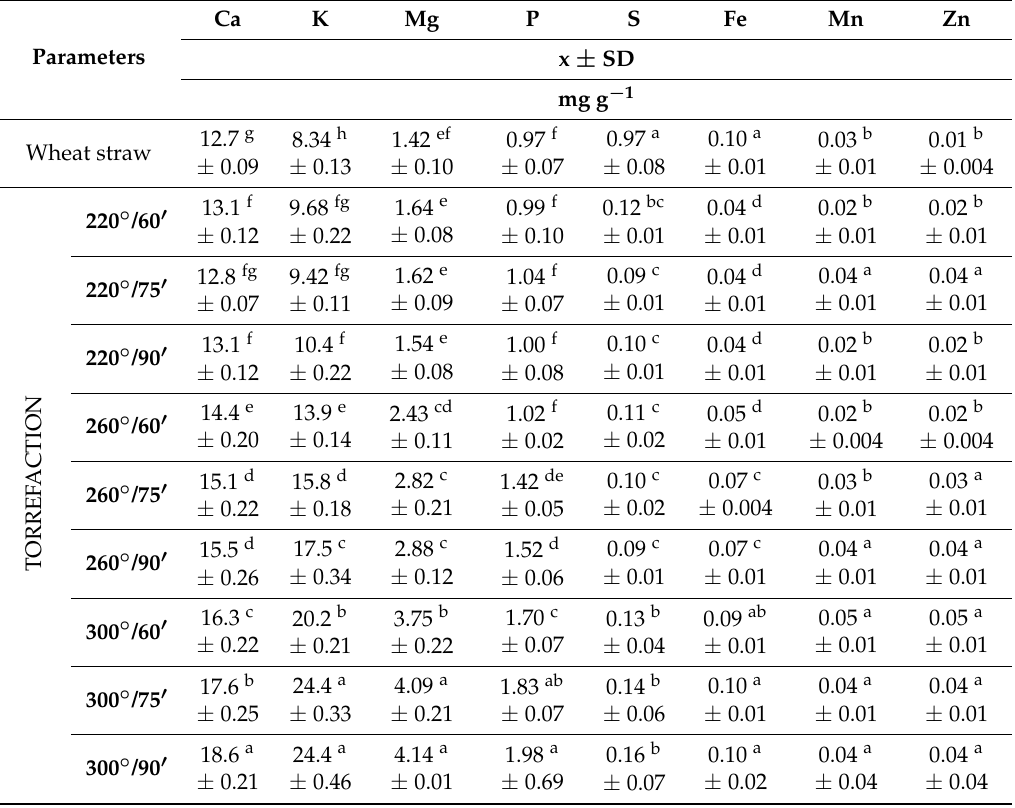
Table 4. The content of Ca, K, Mg, P, S, Fe, Mn, and Zn in wheat straw and torrefied